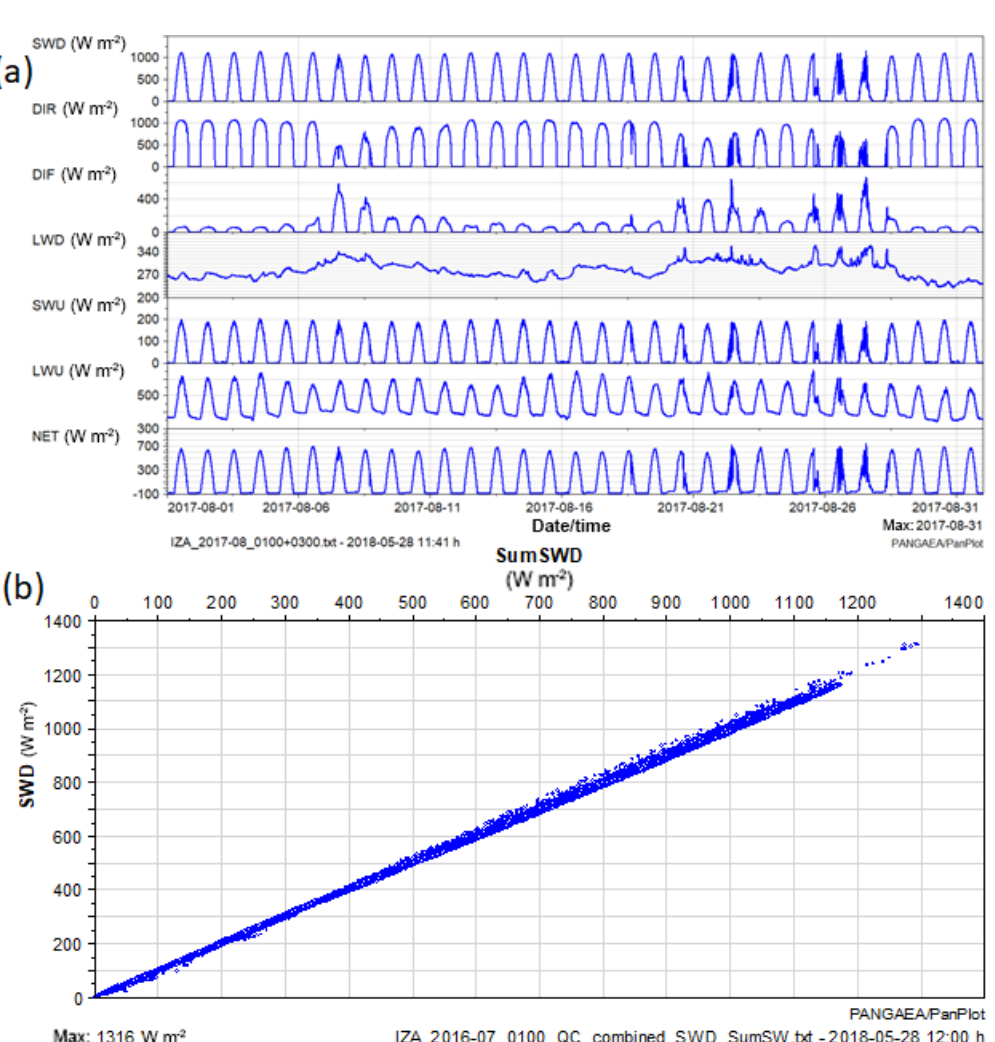
Figure 15. Example of (a) visualization of daily data of SWD, DIR, DIF and LWD radiation at IZA on August 2017 (software: PanPlot; Sieger and Grobe, 2013) and (b) intercomparison between SWD on the x axis and SumSWD (defined as the sum of DIF and DIR on a horizontal plane) on the y axis calculated using the BSRN Toolbox (Schmithüsen et al.,